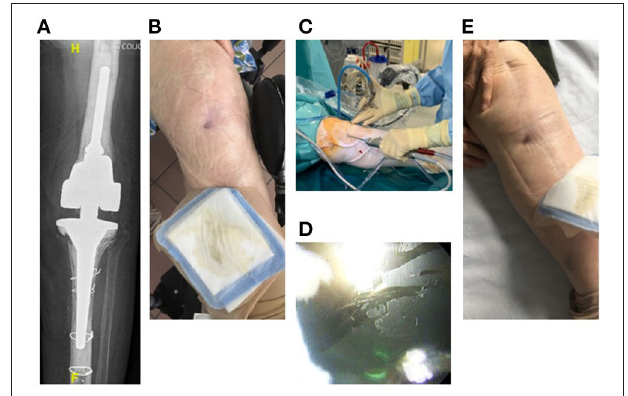
FIGURE 1 | Patient 1 was an 89-year-old woman with past history of recurrent lymphoma, splenectomy, and iterative prosthetic left knee revisions due to relapsing MDR S. epidermidis infection (04/02/2016). She had large constrained cemented prosthesis without loosening (A) and sinus tract (B)